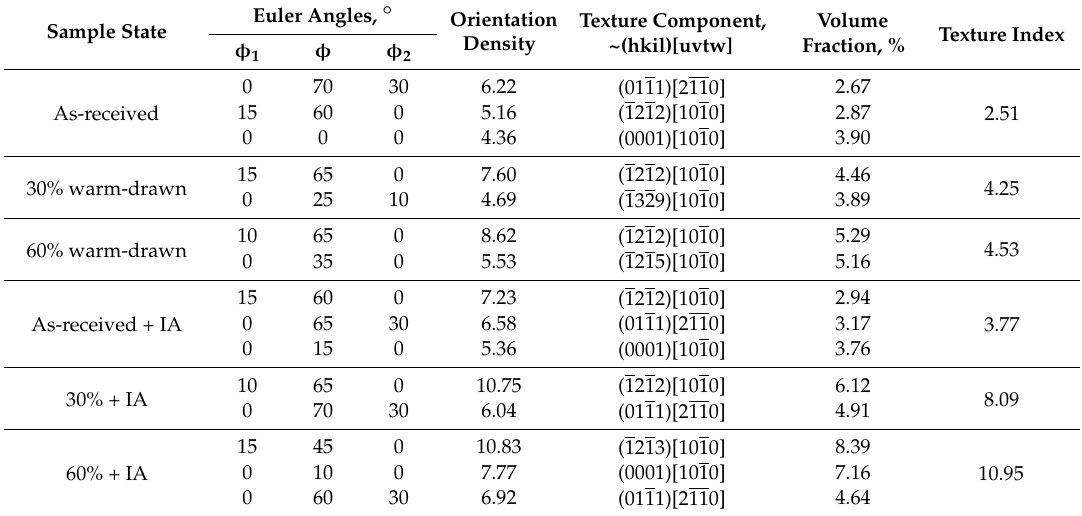
Table 2. Obtained texture characteristics in the alloy after warm drawing and isothermal annealing.